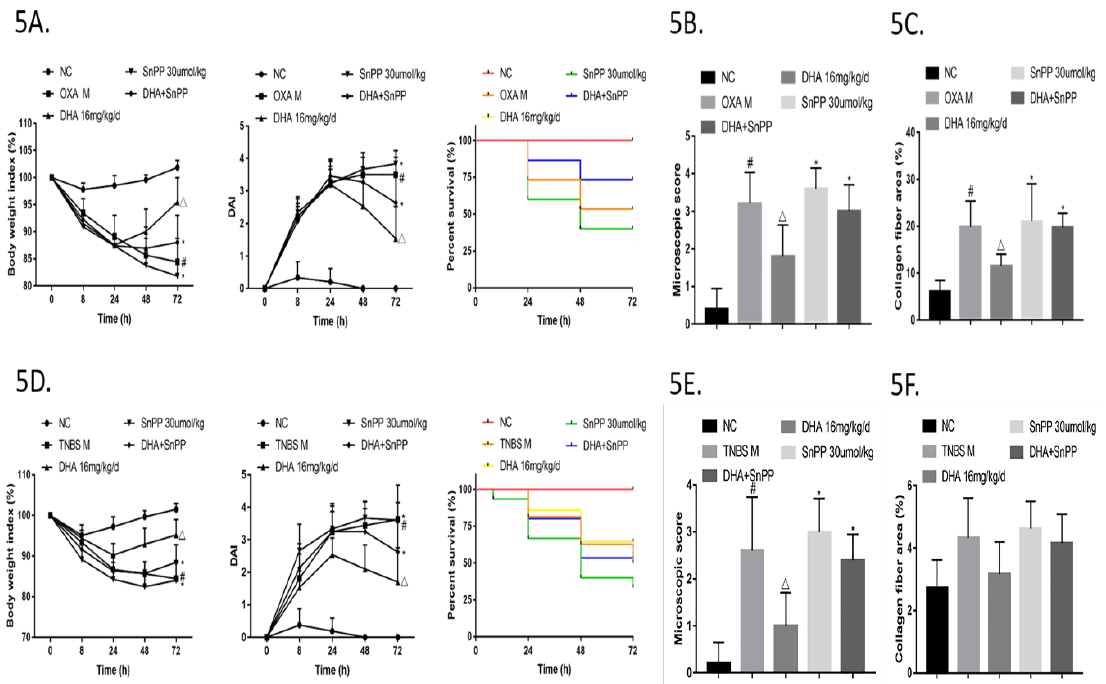
Figure 5. Dihydroartemisinin (DHA) ameliorates oxazolone (OXA)- and 2,4,6-trinitro-benzene sulfonic acid (TNBS)-induced colitis via HO-1. ( 5A ) Inflammatory bowel disease (IBD) was elicited in mice via OXA intracolonic application. Body weight index, disease activity index (DAI) score and mortality